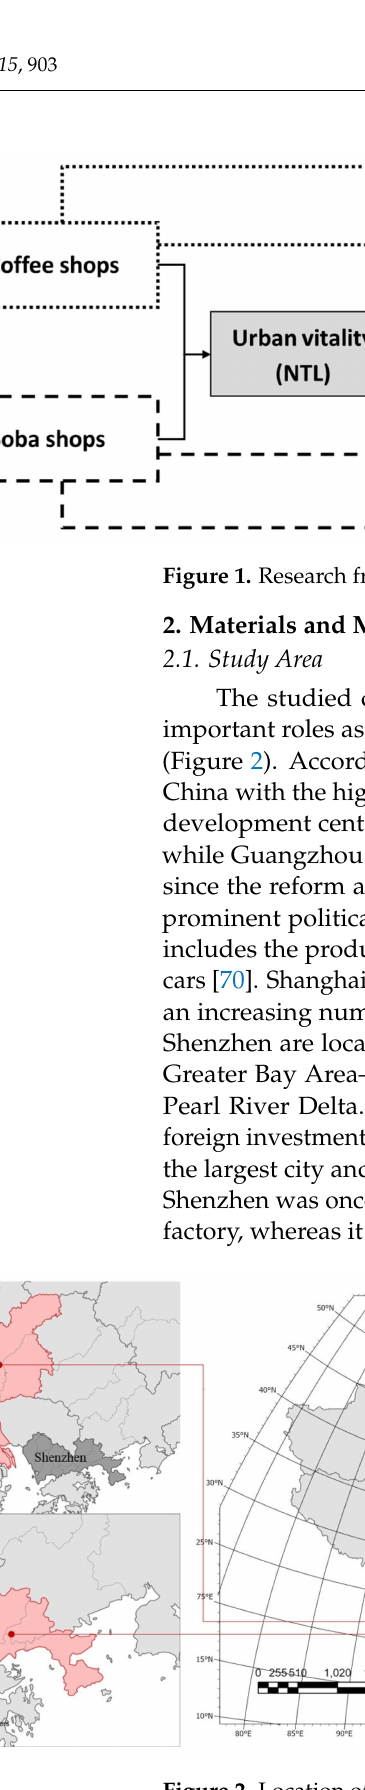
Figure 2. Location of the study